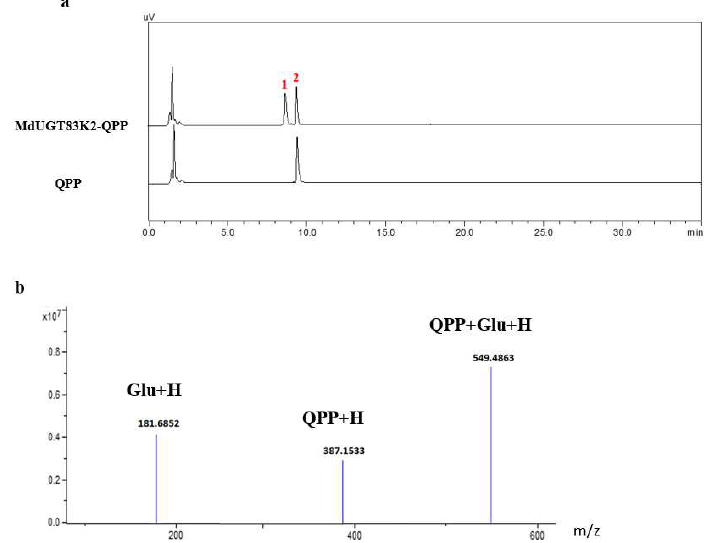
Figure 4. HPLC analysis of reaction products from induced by herbicide QPP by MdUGT83K2. The MdUGT83K2 prokaryotic expression vector was constructed and expressed into E. coli protein strain BL-21, and the MdUGT83K2 enzymatic protein was purified and in vitro enzymatic reaction demon- strated that MdUGT83K2 glycosylation modifies QPP. ( a ): HPLC image, ( b ): mass spectrum. 1, QPP glycosides; 2, QPP.